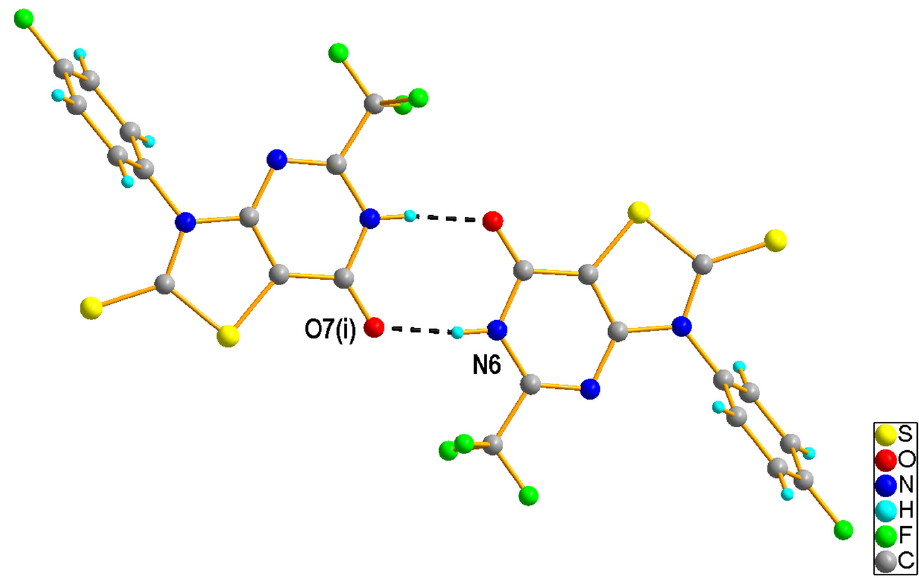
Figure 3. A part of crystal packing of 2e showing the dimer stabilized by N-H ··· O hydrogen bonds (depicted as black dashed lines).